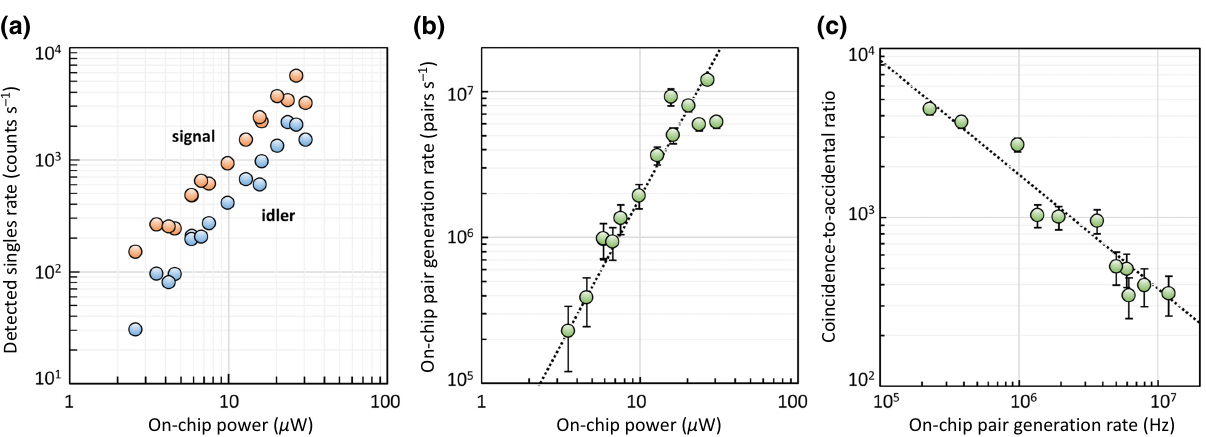
FIG. 3. (a) Corrected detected singles rates versus the on-chip pump power. The difference in the generated singles rates is due to the difference in the filter loss in the two channels (19.4 dB for the idler and 13.6 dB for the signal). (b) The on-chip pair generation rate versus the on-chip pump power. The dashed line is a fit to the data, yielding a pair generation rate of 20 × 10 9 pairs s − 1 mW − 2 (c) The coincidence-to-accidental ratio (CAR) versus the on-chip pair generation